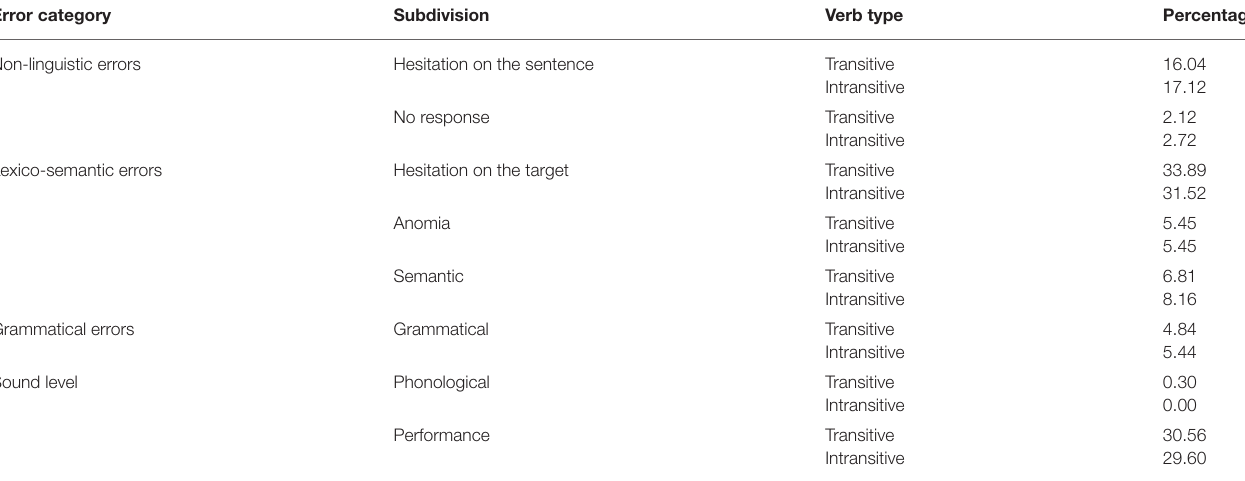
TABLE 1 | Results of the qualitative analysis across hemispheres (percentages of errors).